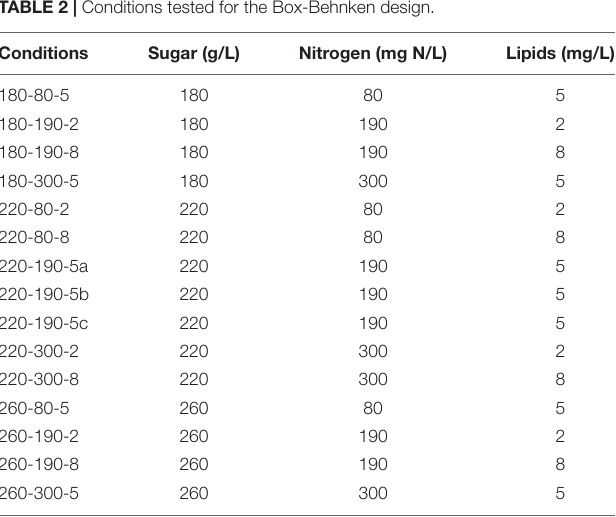
TABLE 2 | Conditions tested for the Box-Behnken